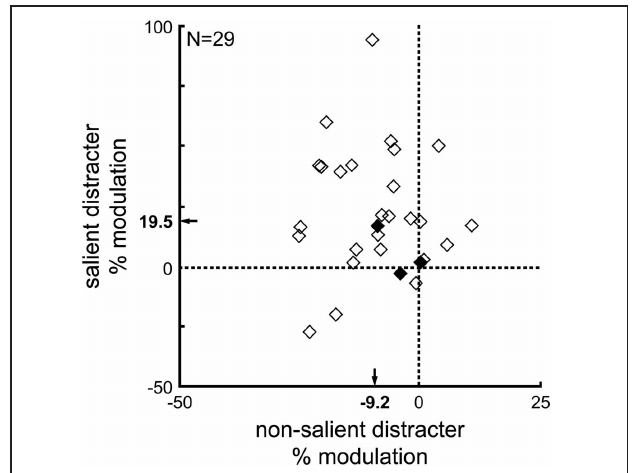
FIGURE 4 | Enhancement in neuronal activity associated with salient distracters and suppression of that associated with non-salient distracters. Percent changes (modulation) were calculated relative to the (baseline) activity in the balanced displays. Each neuron’s activity was computed during a 25ms interval centered on the neuron’s discrimination time. Salient distracters were both the same-color distracter in the few same-color display and the same-shape distracter in the many same-color display. Non-salient distracters were both the same-shape distracter in the few same-color display and the same-color distracter in the many same-color display. Bold axis labels: mean enhancement and suppression. Solid symbols: individual neurons with both activity enhancement and suppression that were not statistically significant (rank-sum test, p > 0 . 05).